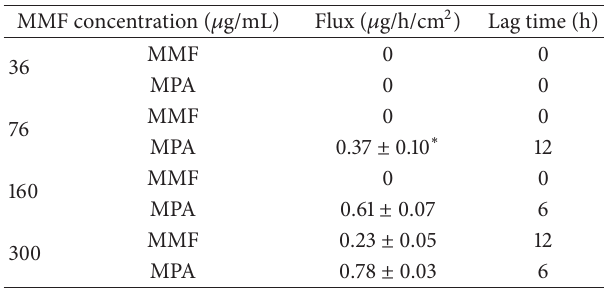
Table 1: The skin permeation flux and lag time of MMF and MPA at various concentrations of MMF